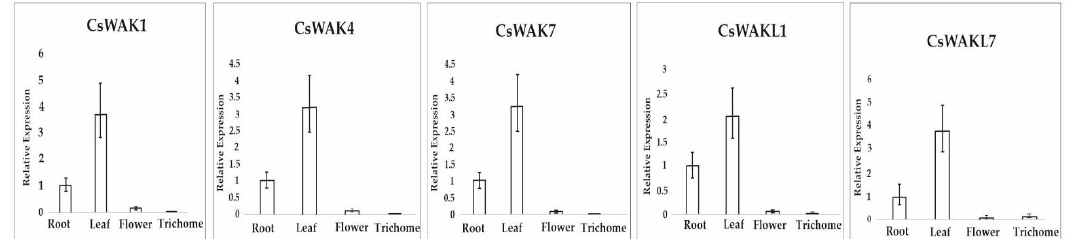
Figure 8. The expression pattern of selected CsWAK/CsWAKL genes in root, leaf, flower, and trichome. The ∆∆ CT method was used for calculations. X-axis refers to different tissues. Data are presented as means ± SE (n = 3): mean separation between expression in various tissues compared with the level in the root.